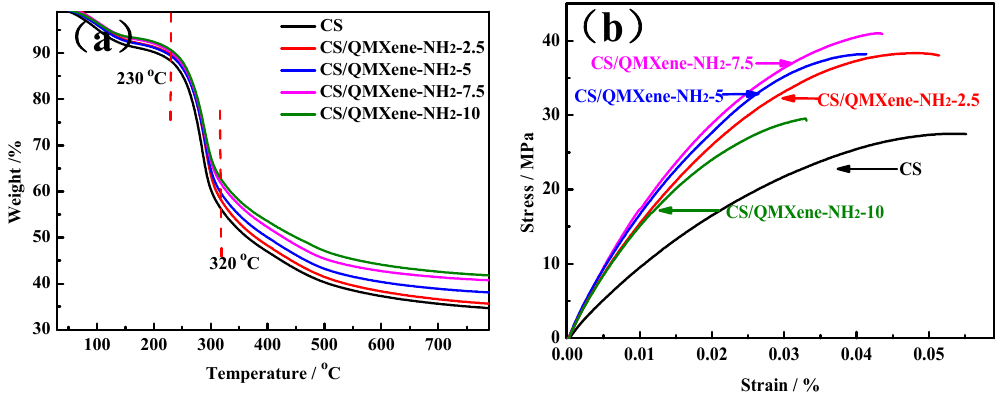
Figure 7. ( a ) TGA curves and ( b ) stress-strain curves of control CS and CS/QMXene-NH 2 membranes.